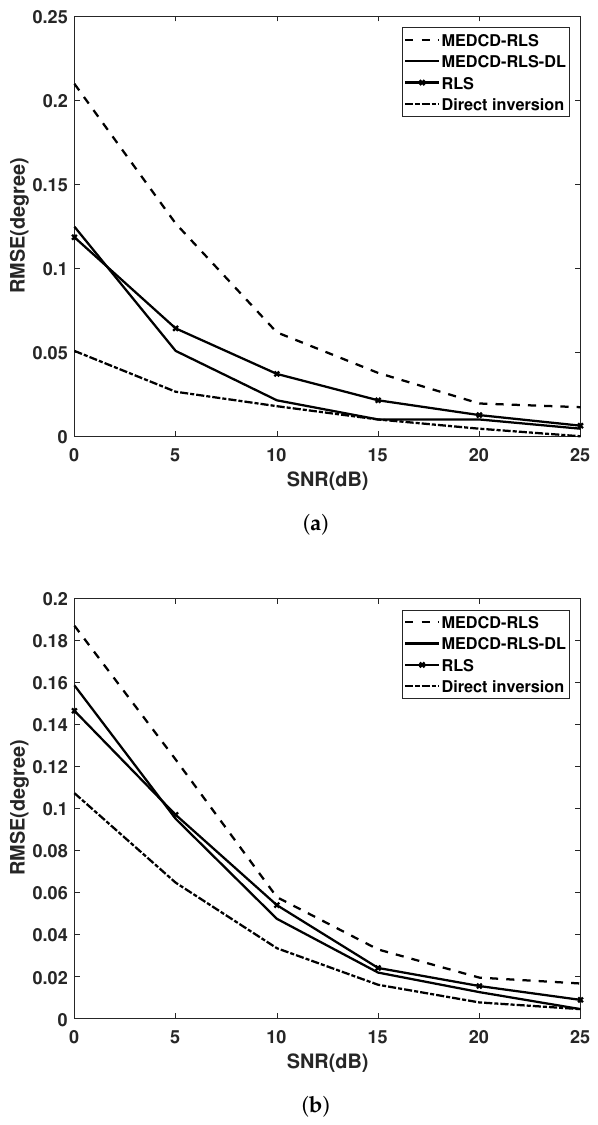
Figure 3. RMSE vs. SNRs for θ true = { 30 ◦ ,50.6 ◦ } . ( a ) θ true = 30 ◦ . ( b ) θ true = 50.6 ◦ . A rough DoA estimate can be attained with reduced complexity by using the MEDCD- RLS-DL DoA estimator. For a more accurate estimation, a small angular interval can be set around the crudely estimated DoA, and the desired DoA can be achieved by choosing the peak power from the calculated received power of the MVDR DoA estimator. Figure 4 visualises the three-step process of estimating the θ true = 37.5 ◦ DoA with different scanning intervals. At each snapshot i , the DoA estimation is performed in three steps. At step 1, the scanning steering vector Φ s ( θ p ) is obtained from − 90 ◦ to 90 ◦ with an interval of 5 ◦ . Note that the estimator has a clear magnitude peak at approximately 40 ◦ . At step 2, we take the DoA estimated from step 1 in the centre and window the scanning range to 5 ◦ on both the left and right of the estimated DoA with a scanning interval of 1 ◦ . Here, the estimated DoA is approximately 38 ◦ . At step 3, the scanning range is a total of 2 ◦ with 38 ◦ at the centre, and the scanning interval is 0.1 ◦ . There is a magnitude peak at 37.5 ◦ . This example shows that the scanning interval resolution affects the estimation accuracy. Although the coarse DoA estimation (step 1) is computationally efficient, the fine DoA estimation (step 2, step 3) requires more scanning statistical data to achieve a certain accuracy, which results in an increase in the